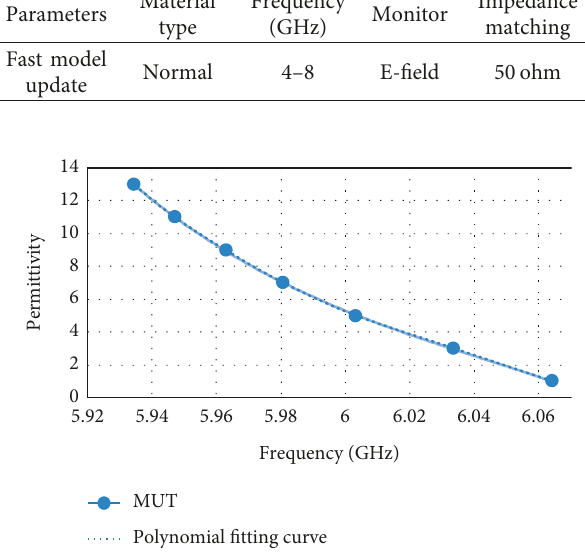
Figure 10: Simulated polynomial fitting curve of the permittivity. Thus, the extracted equation is given by